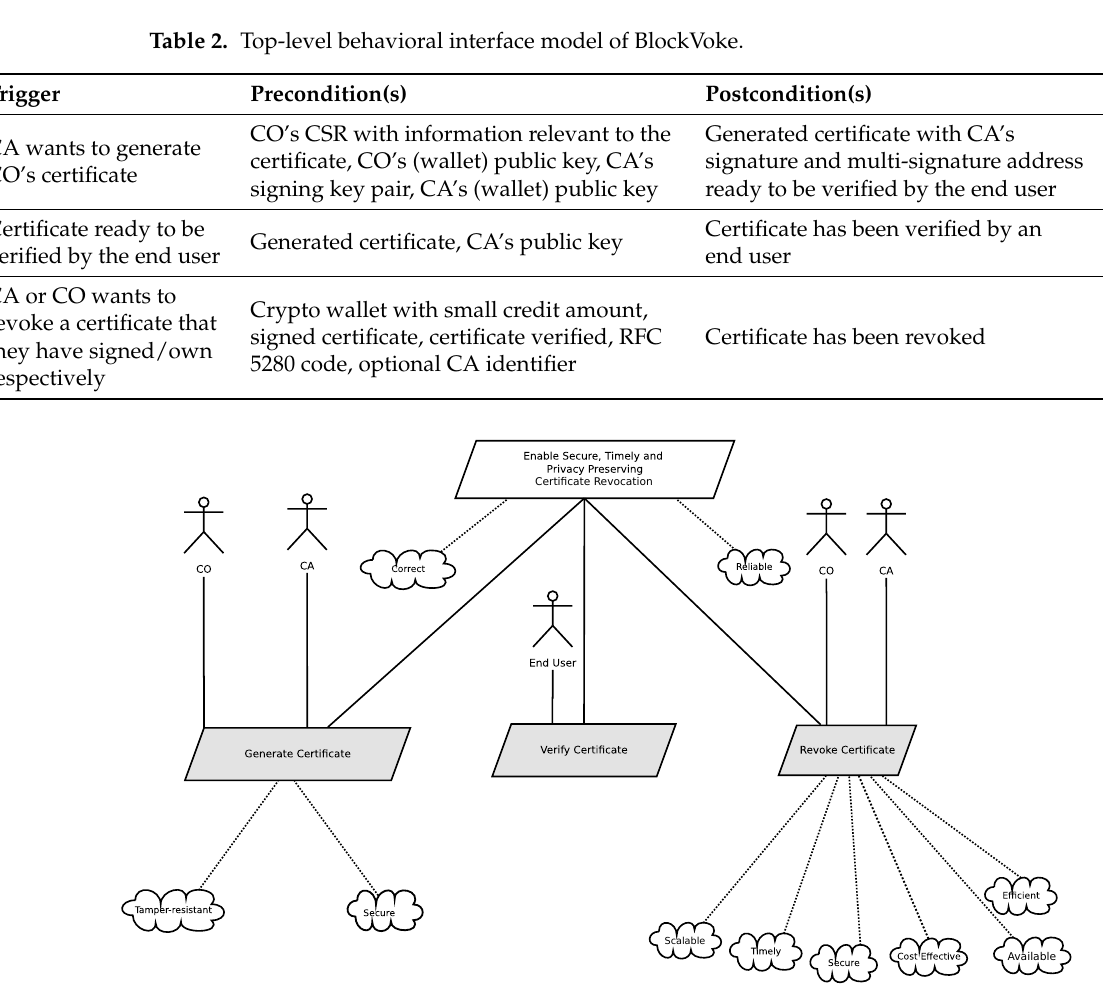
Figure 5. Top-level goal model of